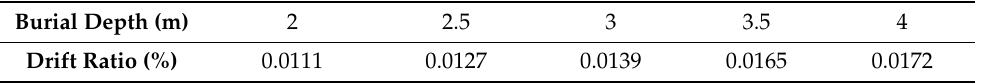
Table 3. Maximum drift ratios of the structures in the five numerical models during the earthquake.